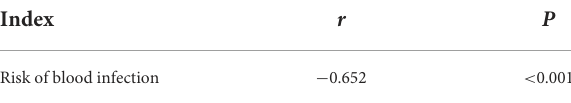
TABLE 7 Correlation between blood infection and APACHE II